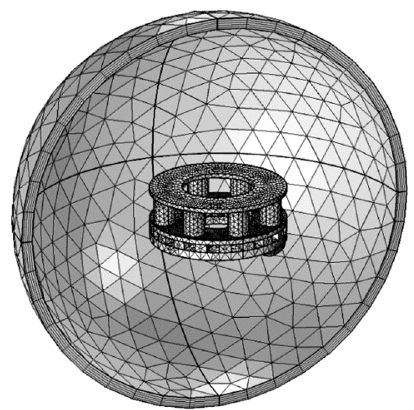
Figure 4. Calculation model of the integrated brake after meshing.